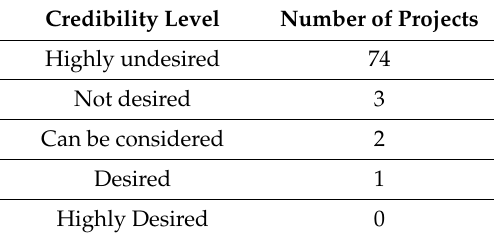
Table 8. Statistical analysis of credibility assessment of suspended projects (Total projects =